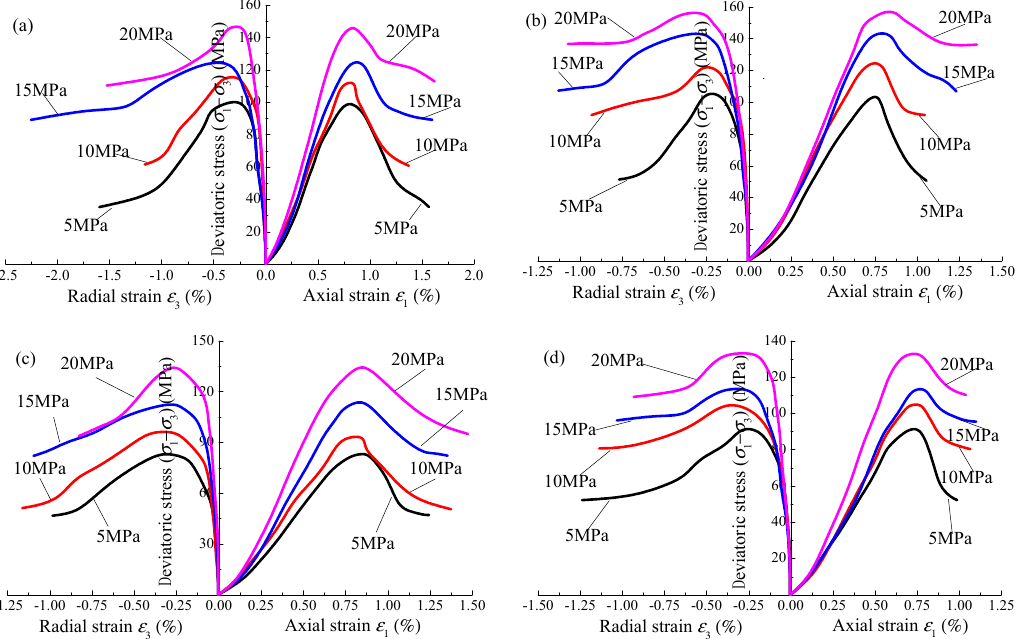
Figure 2. Stress–strain curves of Na 2 SO 4 corroded sandstone under triaxial loading: ( a ) α = 0.02 mol · L − 1 , pH = 2; ( b ) α = 0.02 mol · L − 1 , pH = 12; ( c ) α = 0.04 mol · L − 1 , pH = 2; ( d ) 0.10 mol · L − 1 , pH = 2.